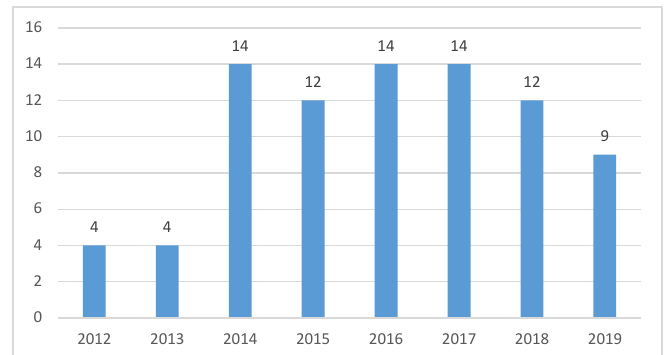
Figure 4. Distribution of papers during 2012–2019.